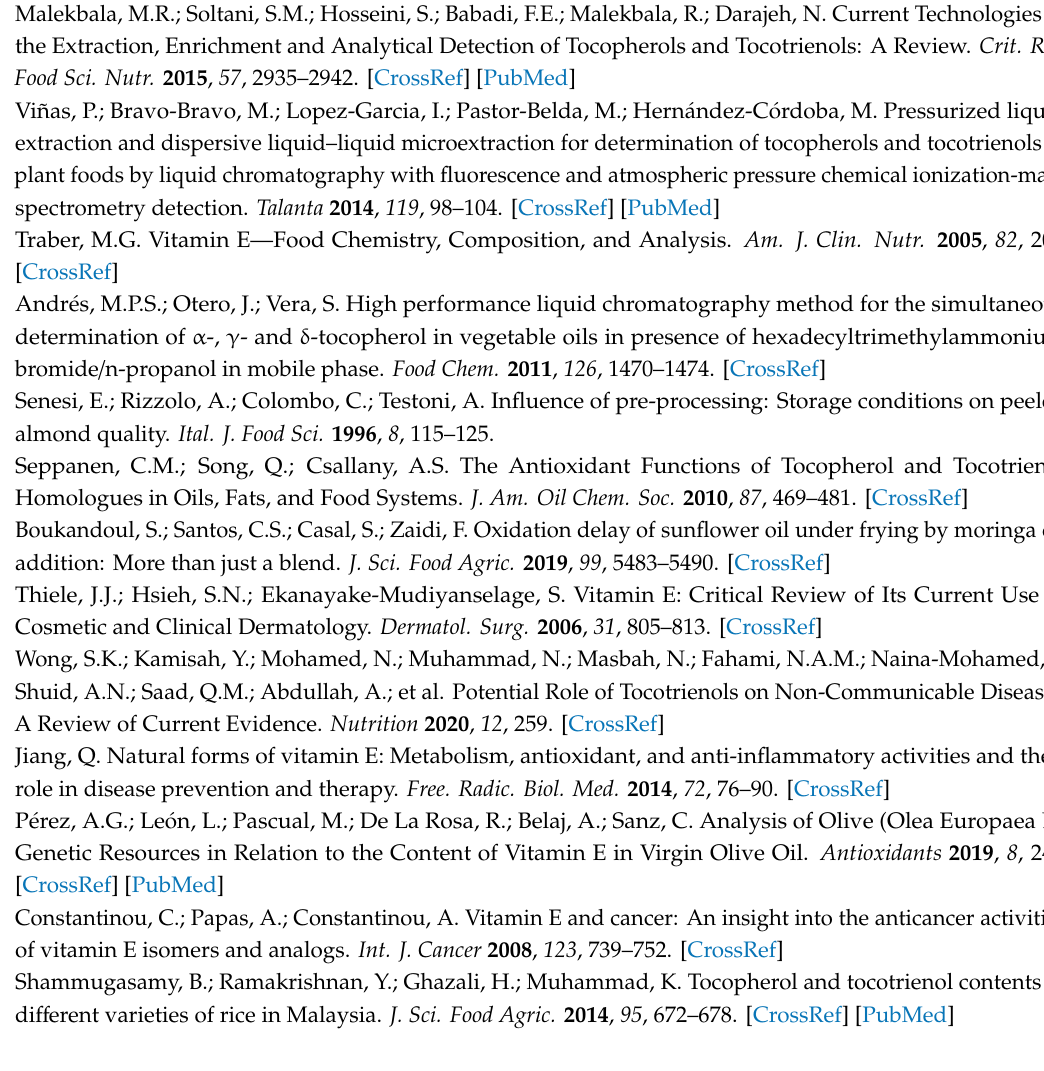
Supplementary Materials: Figure S1: Flowchart depicting the refining process of the crude new types of vegetable oil. Figure S2: Representative chromatograms of the working standard mixtures, refined sumac fruit oil sample and refined sacha inchi oil sample. Table S1: Correlation coe ffi cient, recovery, intraday precision, interday precision, LOD and LOQ of the tocols analyzed by